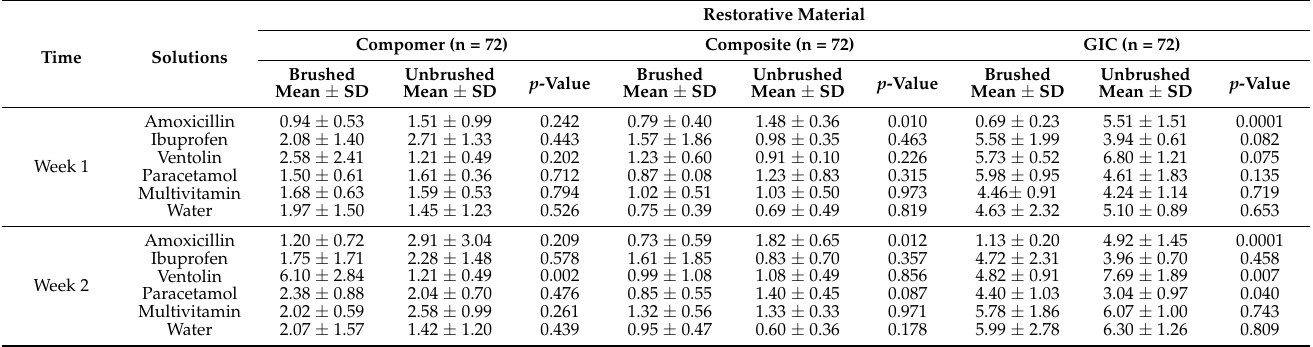
Table 4. Effect of pediatric drugs and brushing on color change in the